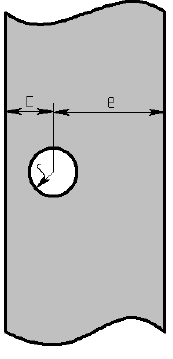
Fig. 5. Defect – shifted circular hole.